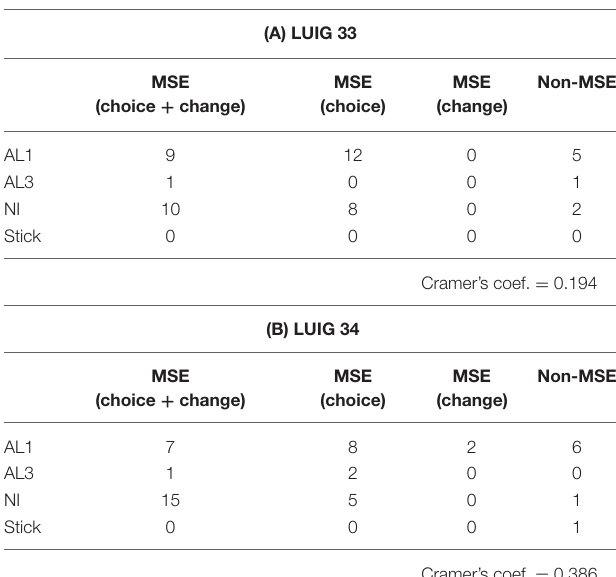
TABLE 1 | Classification of subjects by observed behavior in the laboratory and the estimated learning